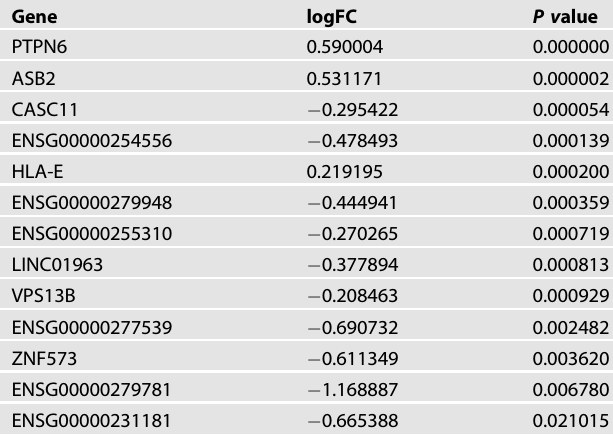
Table 1. Genes with altered expression that showed up in sequencing data from both guides against LNROP and